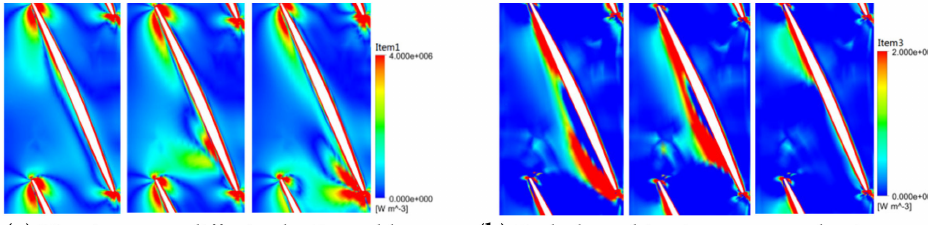
Figure 10. Distribution of the losses for intake ( left : 0.5 Ud, middle : 1.0 Ud, right : 1.7 Ud).